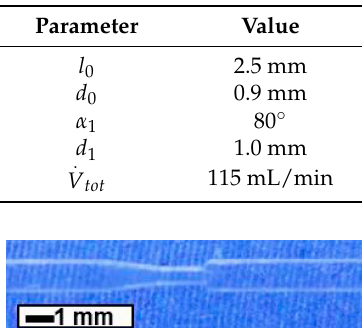
Table 5. Optimum factor setting for efficient turbulent bubble breakup.